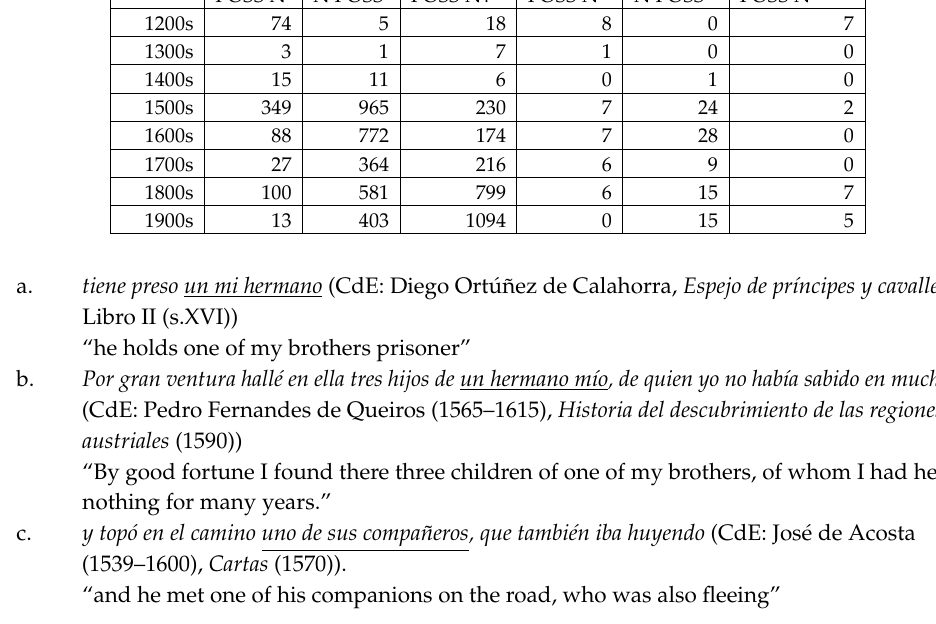
Table 13. Demonstrative + POSS + N in CdE (raw